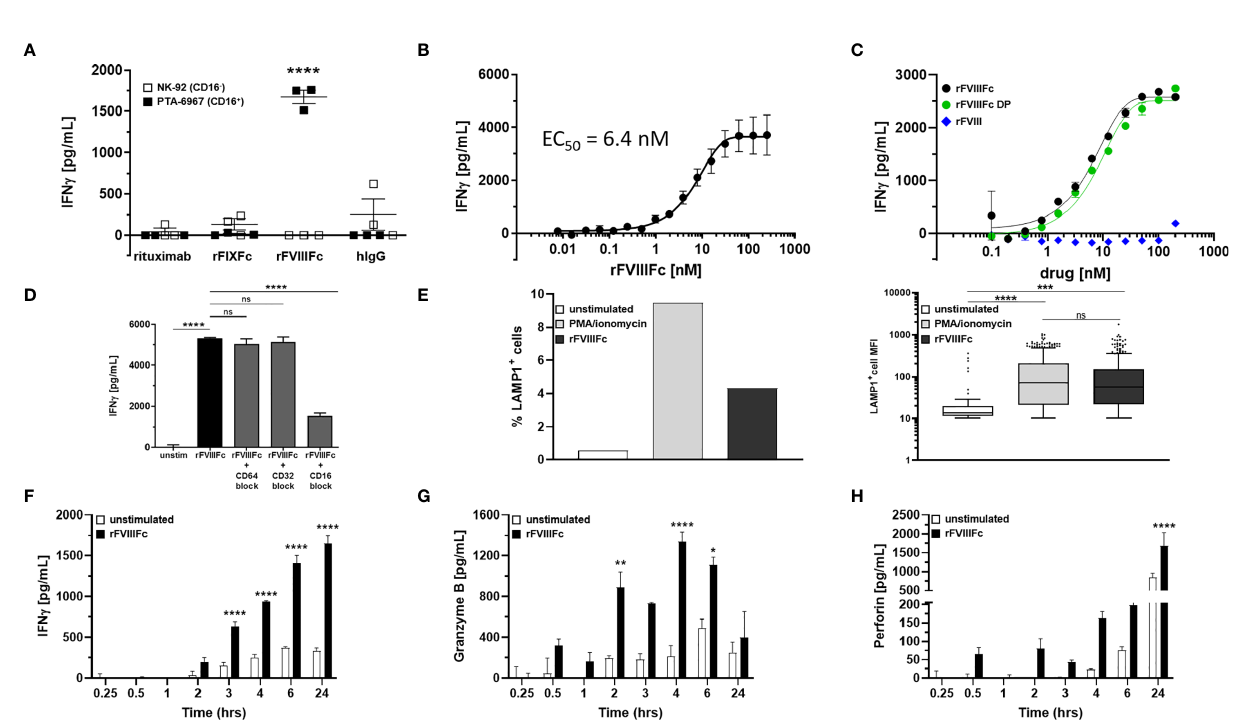
FIGURE 2 | rFVIIIFc activates and induces degranulation by CD16 + NK cells. (A) IFN g secretion by CD16 - NK cells (NK-92; open squares) or CD16 + NK cells (PTA- 6967; fi lled squares) measured by ELISA following overnight incubation with 67 nM human IgG1 Fc-containing proteins [rituximab; rFIXFc; rFVIIIFc; human polyclonal IgG]; plotted as mean ± SEM (n=3) from a representative of two experiments. Tukey ’ s multiple comparisons tests (two-tailed) were performed for each protein between stimulated CD16 - NK cells (open squares) and stimulated CD16 + NK cells ( fi lled squares). ****p < 0.0001. (B) Secreted IFN g response of CD16 + NK cells (PTA-6967) following overnight stimulation with different concentrations of rFVIIIFc (250 nM to 7.6 pM); plotted as mean ± SEM (n = 6) from 2 independent experiments. (C) Secreted IFN g response of CD16 + NK cells (PTA-6967) as above with rFVIIIFc protein (black circle), rFVIIIFc DP (green circle), or rFVIII (blue diamond) (200 nM to 98 pM); plotted as mean ± SEM (n = 2) from a representative of two experiments. (D) IFN g secretion by CD16 + NK cells (PTA-6967) stimulated with rFVIIIFc (250 nM). For Fc g R blockade, CD16 + NK cells were pre-incubated with Fc g R-speci fi c F(ab ’ ) 2 fragments prior to stimulation with rFVIIIFc; plotted as mean ± SEM (n = 4). Tukey ’ s multiple comparisons tests (two-tailed) were performed between (i) unstimulated controls and rFVIIIFc stimulated and (ii) rFVIIIFc stimulated ± Fc g R blockade. ****p < 0.0001. (E) Left, bar graph depicting surface CD107a (LAMP1) levels (% LAMP1 + cells), an indirect measure of degranulation, measured on NK cells (PTA-6967) from a single fl ow cytometry experiment following a 6-hour stimulation with PMA/ionomycin (50 ng/mL PMA, 1 µg/mL ionomycin) or rFVIIIFc (250 nM); right, Tukey box-and-whiskers plots depicting LAMP1 + cell mean fl uorescence intensity (MFI). One-way ANOVA and Tukey ’ s multiple comparisons test performed, ***p = 0.0004, ****p < 0.0001. (F – H) Measurement of secreted IFN g (F) , granzyme B (G) , and perforin (H) by ELISA over time from rFVIIIFc-stimulated (67 nM) CD16 + NK cells (PTA-6967) plotted as mean ± SEM (n = 3). Tukey ’ s multiple comparisons tests (two-tailed) were performed at each timepoint between unstimulated cells (open bars) and rFVIIIFc stimulated cells ( fi lled bars). *p < 0.05, **p < 0.01, ****p < 0.0001. ns, not signi fi cant, p >